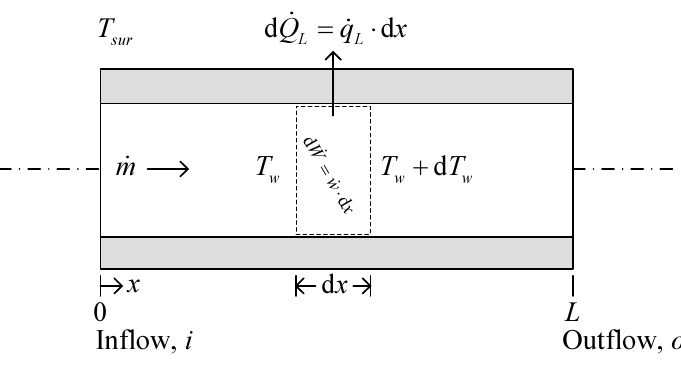
Figure 2. Control volume for the internal flow in a